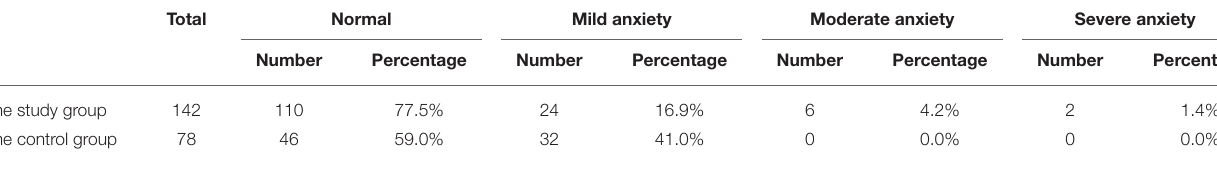
TABLE 3 | Severity of anxiety in the study and control